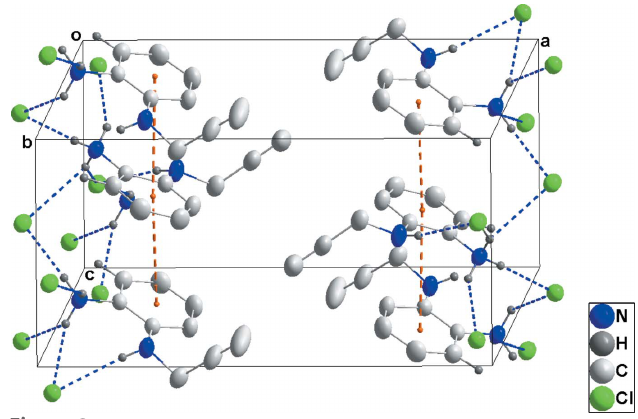
Figure 3 Overall packing viewed along the b -axis direction with (cid:2) – (cid:2) stacking interactions shown as dashed orange lines.